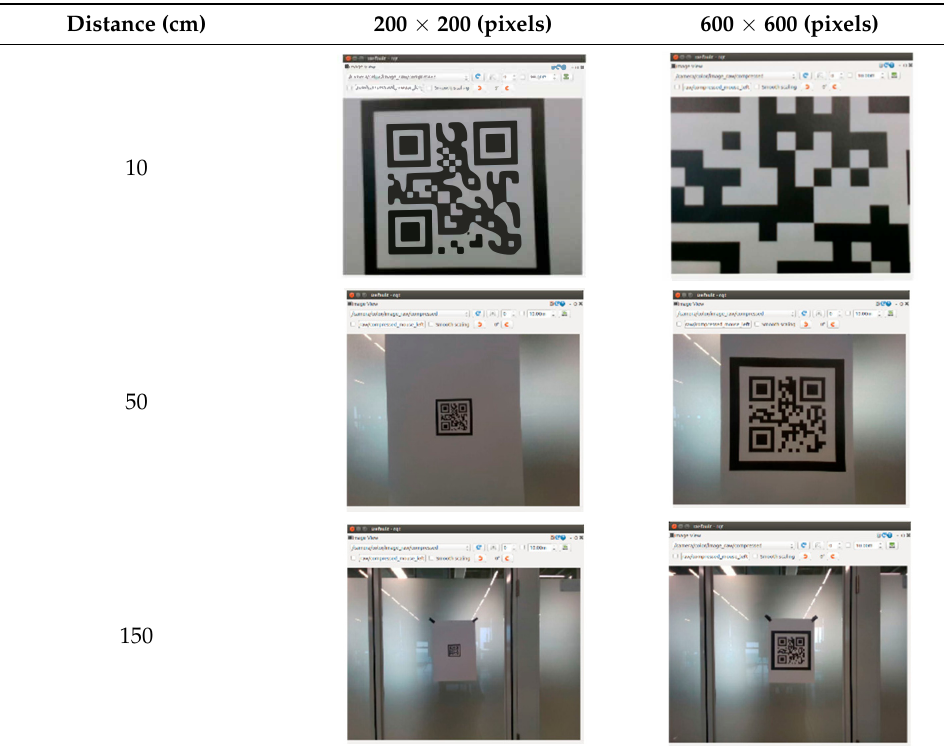
Table 1. Images of markers at different